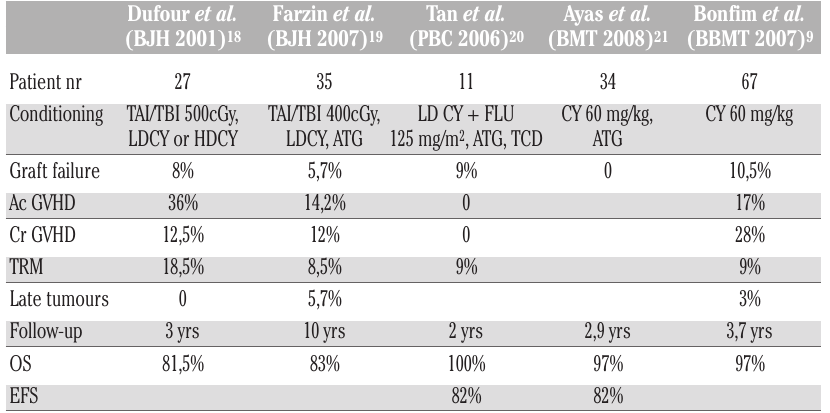
Table 1. Matched family donor transplant: conditioning regimen and outcome. Dufour et al.